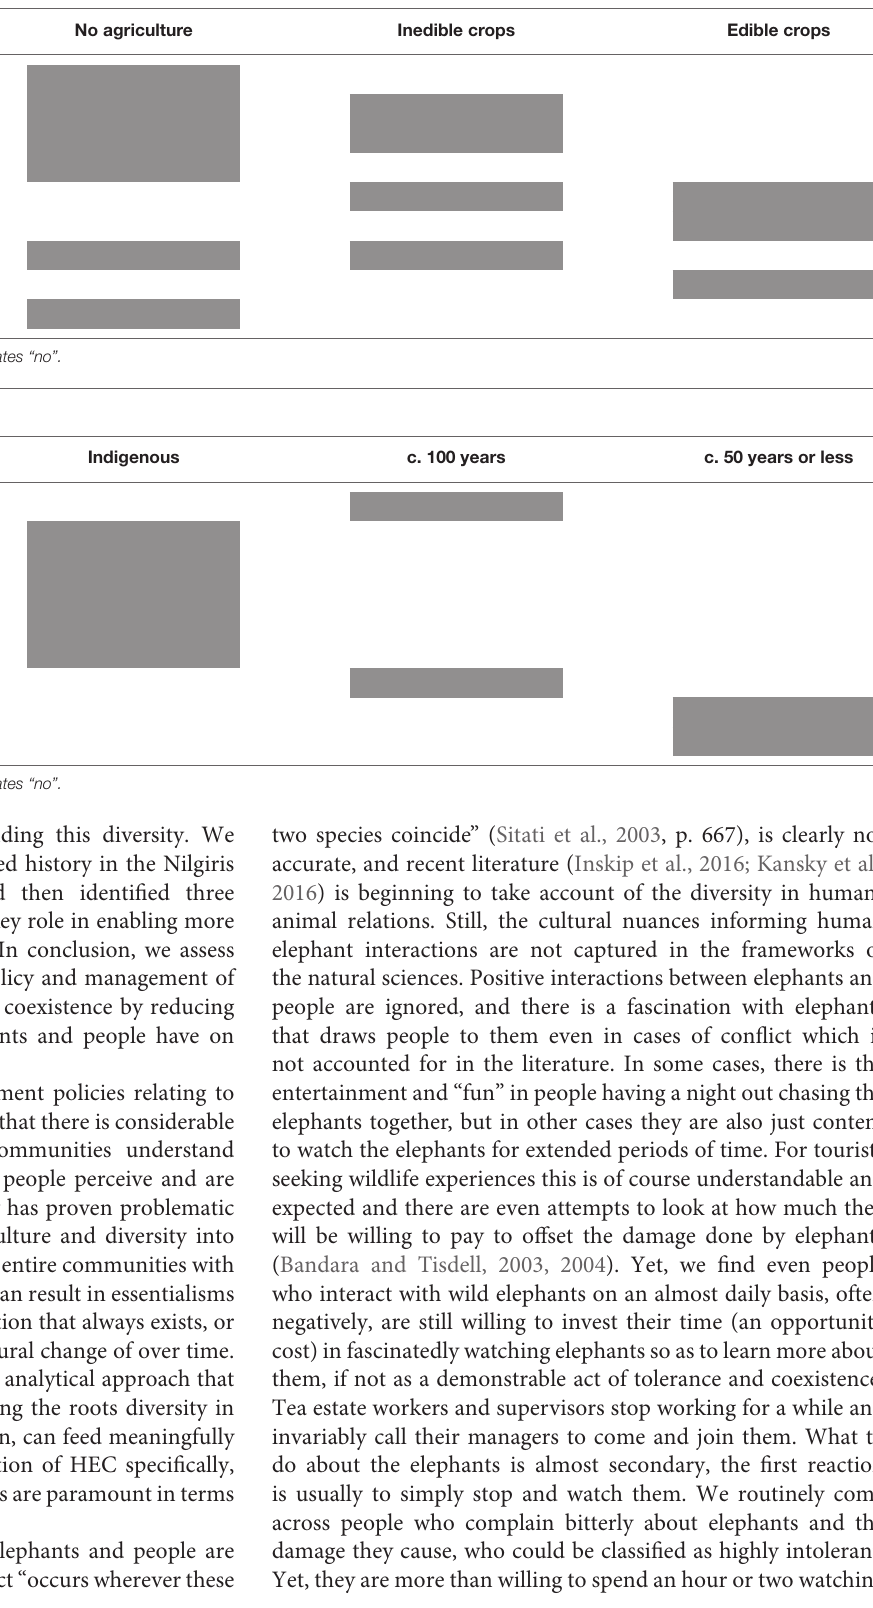
TABLE 5 | Varying agricultural practices.